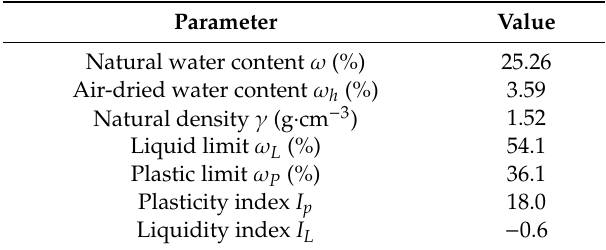
Figure 2. The soil used in the tests. Table 2. Basic parameters of the clay.